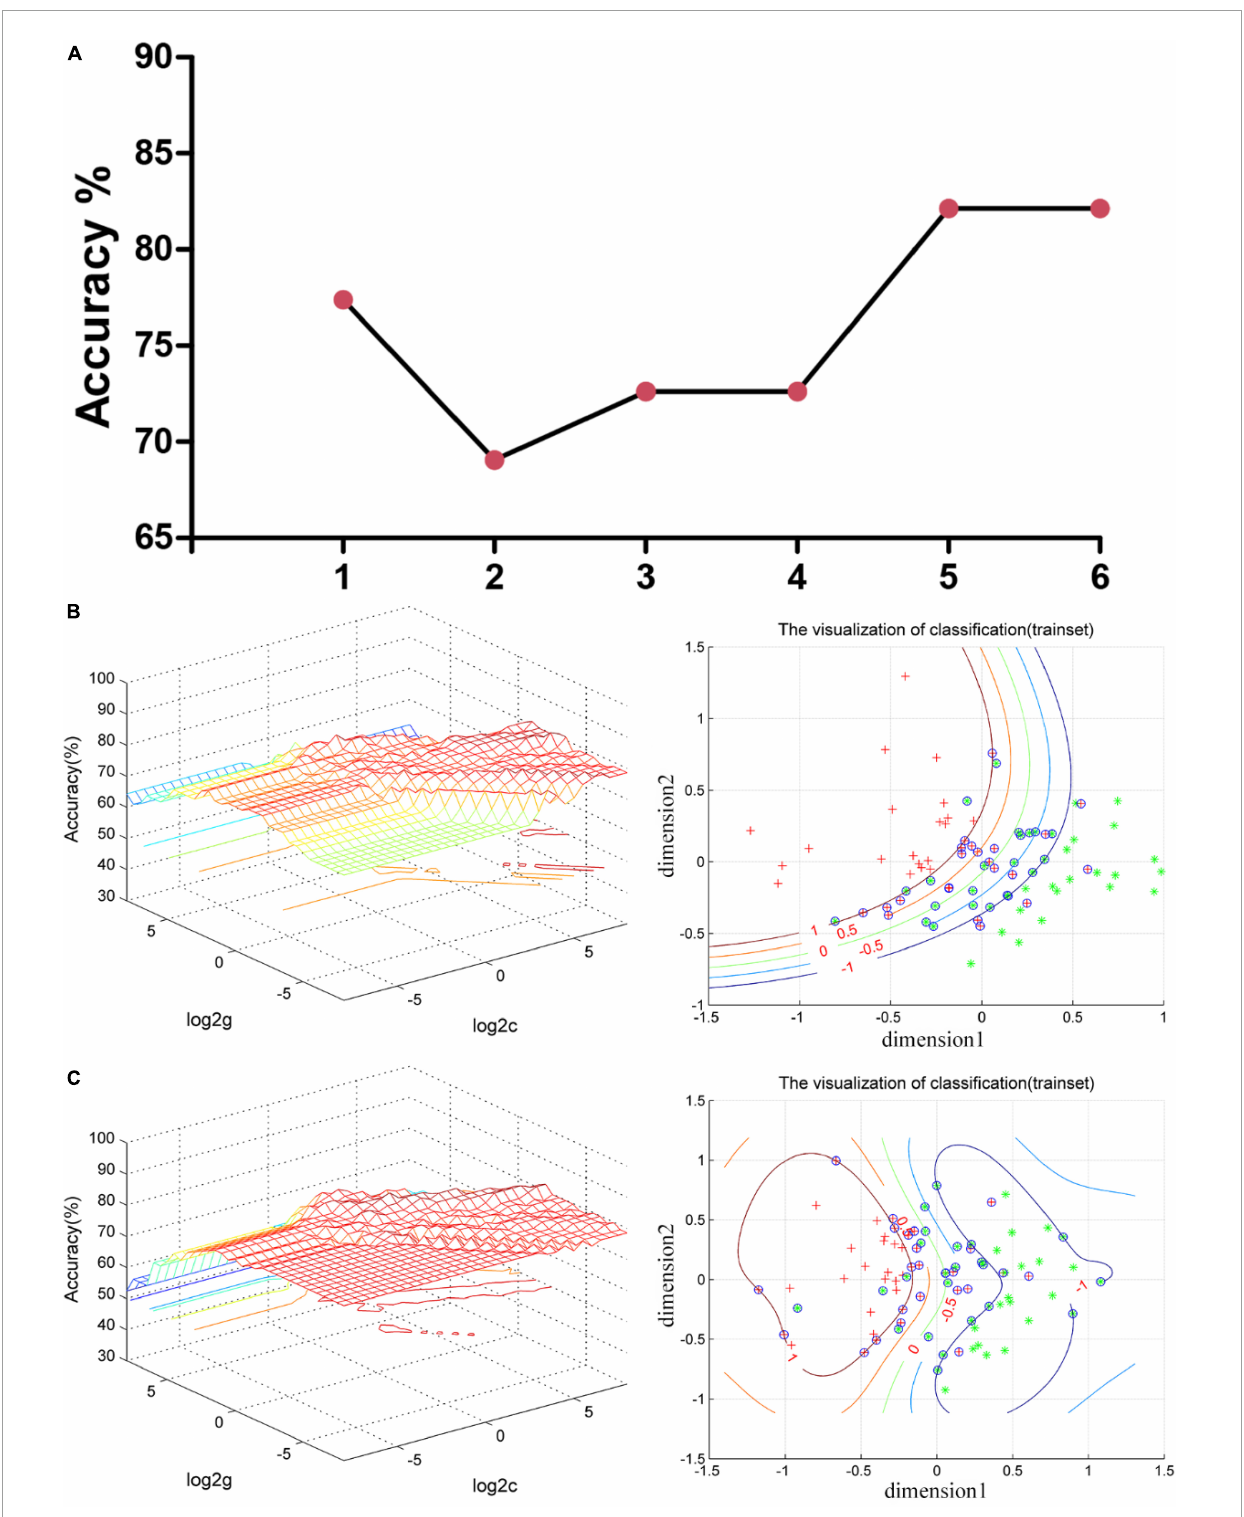
FIGURE2 Support vector machine (SVM) results. (A) The accuracy of classification of six SVM analyses. One represents the VMHC values in the cerebellum 8/vermis 8/vermis 9; 2 represents the VMHC values in the superior/middle occipital gyrus; 3 represents the VMHC values in the insula; 4 represents the combination of the VMHC values in the cerebellum 8/vermis 8/vermis 9 and superior/middle occipital gyrus; 5 represents the combination of the VMHC values in the cerebellum 8/vermis 8/vermis 9 and insula; and 6 represents the combination of the VMHC values in the superior/middle occipital gyrus and insula. (B) SVM analysis applied the combination of the VMHC values in the cerebellum 8/vermis 8/vermis 9 and insula. Sensitivity = 80.95%, specificity = 83.33%, and accuracy = 82.14%. In the left part, the red cross represents patient with MDD, and the green asterisk represents healthy controls. The blue circle represents support vector. (C) SVM analysis applied the combination of the VMHC values in the superior/middle occipital gyrus and insula. Sensitivity = 78.57%, specificity = 85.71%, and accuracy = 82.14%. In the left part, the red cross represents patient with MDD, and the green asterisk represents healthy controls. The blue circle represents support vector. SVM, support vector machines; VMHC, voxel-mirrored homotopic connectivity; MDD, major depressive